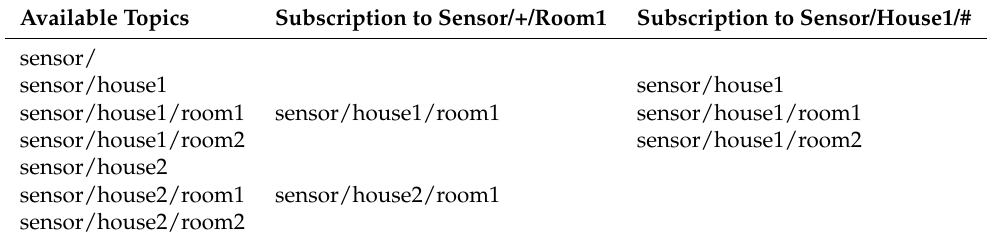
Table 1. Example of topic wildcard